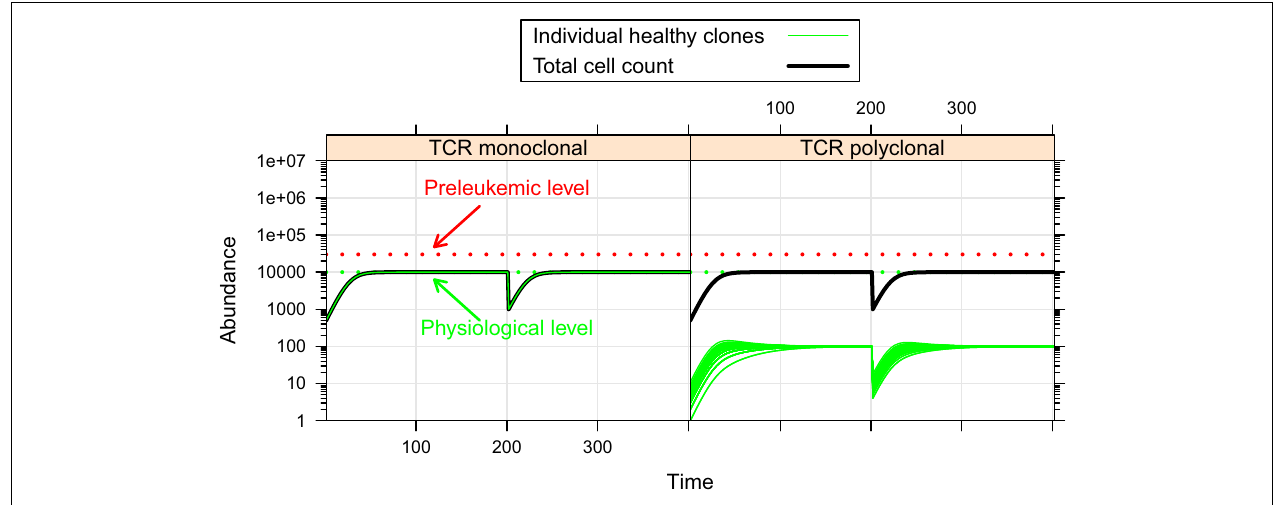
dashed green line at 10 4 .The horizontal red line at 3 × 10 4 represents the total cell count that is required as a minimum in order to qualify a situation as premalignant. At t = 200, 99% of the cells are removed from the system. Both in the mono- and the polyclonal situation the system quickly reestablishes the previous steady